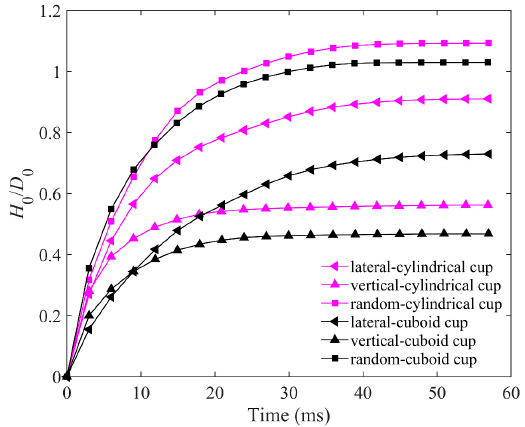
Figure 22. Comparison between H 0 / D 0 for three packing types in cylindrical cup and cuboid cup.